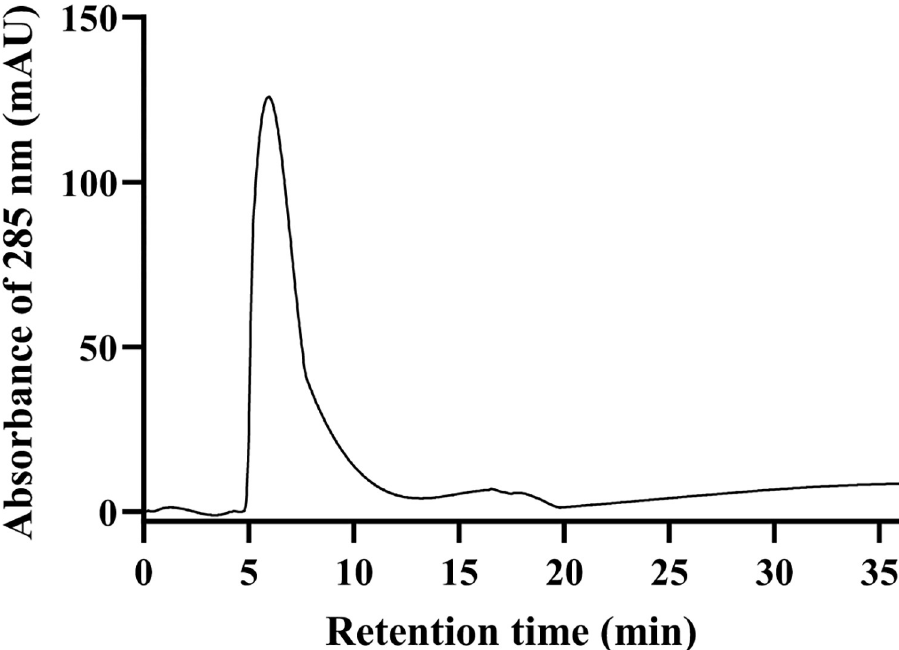
Fig 3. The RP-HPLC profile of hesperidin isolated from C. limetta with yielded of 98.8%.